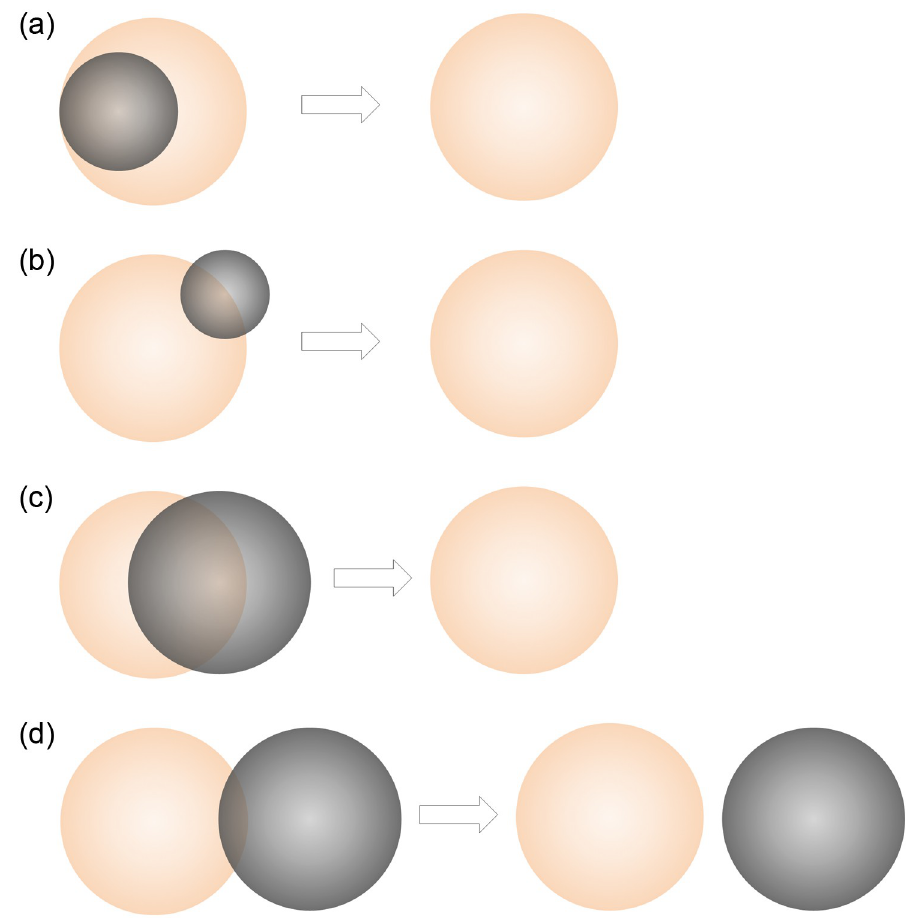
Fig 3. (Color online)Mechanism of eliminating overlapping region. In (a), (b), and (c), the light gray circles are noise, and in (d), both circles are real rebars and will be retained. (a) An object is entirely contained in another